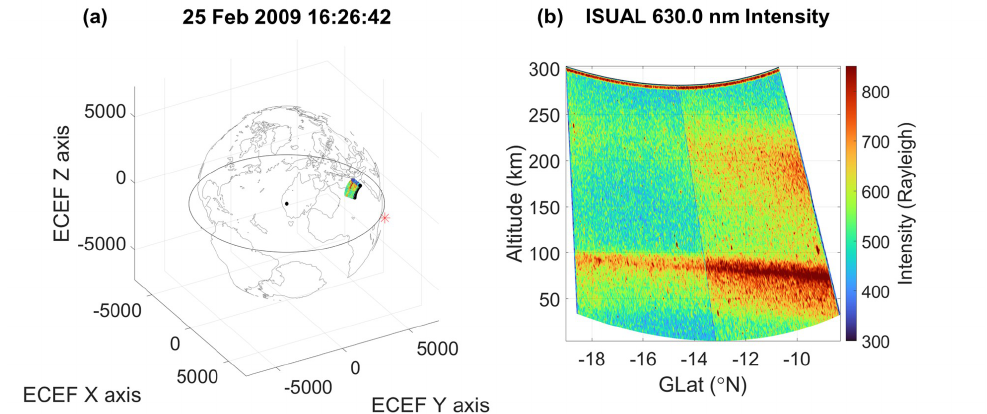
Figure 1. The FORMOSAT–2/ISUAL captured 630.0 nm airglow emission intensity (unit: Rayleighs) on 25 February 2009 at 16:26:42 Universal time. ( a ) The ECEF position of FORMOSAT-2 (red star) and the image (contour). ( b ) The 630.0 nm emission intensity is within 50–300 km. The vertical and horizontal axes indicate the tangent altitude and geographic latitude ( ◦ N),